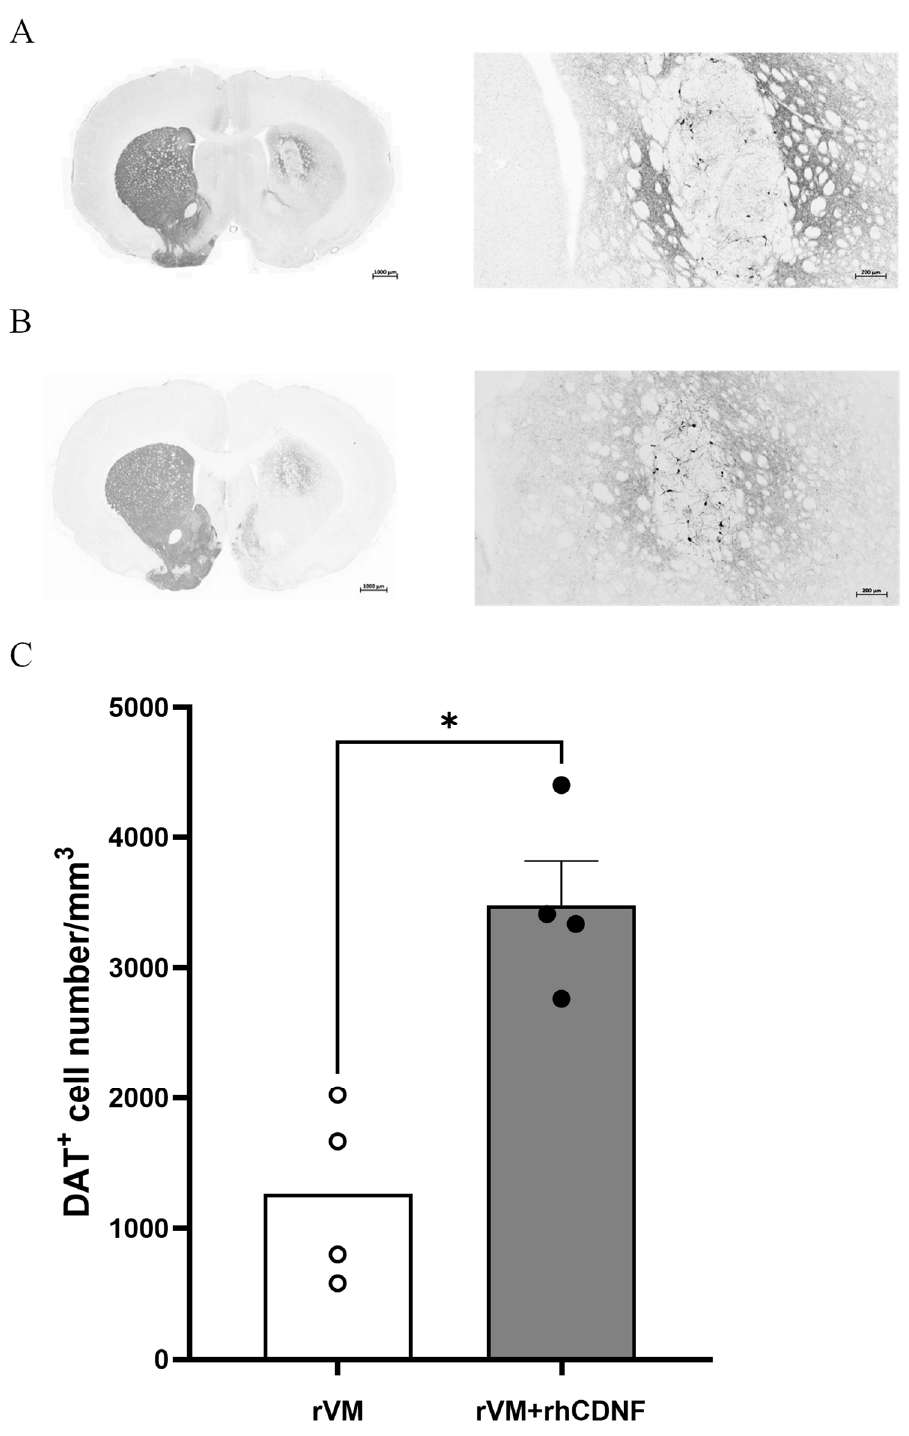
Figure 5. Photomicrographs of DAT immunoreactive (DAT − ir) cells in hemiparkinsonian rat striatum at 8 weeks following transplantation. DAT − ir cell bodies in the grafted side (right side of coronal brain sections) of the rVM and rVM + rhCDNF groups. Higher density of DAT − ir cells was found in the rVM + rhCDNF group as compared to the rVM group. ( A ) Rvm group. ( B ) rVM + rhCDNF group. ( C ) Quantification of DAT-ir cell density. * p < 0.05 vs. rVM and rVM + rhCDNF. N = 4 rats in each